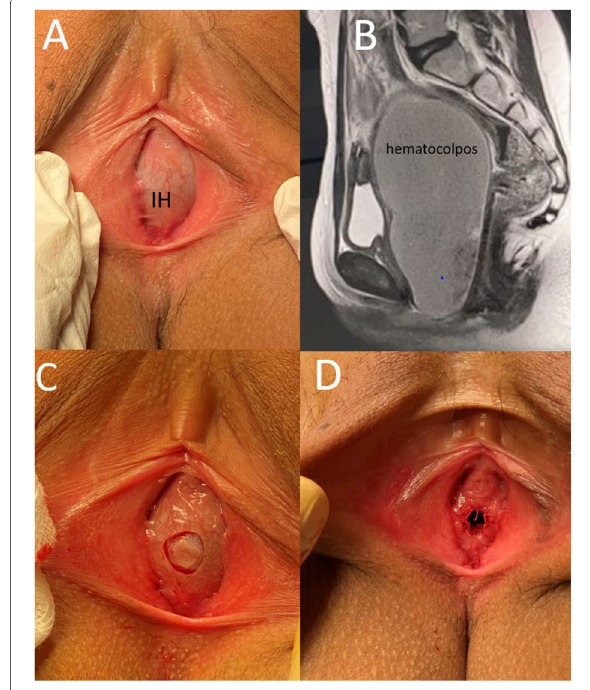
Fig. 1 Hymen-saving central annular hymenotomy (HSCAH) in adolescent. A Imperforated hymen (IH) with Valsalva maneuver showing increased bulging of imperforate hymen membrane. B Magnetic resonance image (MRI) showing massive hematocolpos occupying the pelvic cavity. C Demarcation of central annular incision. D Completed primary central annular excision of the hymenal membrane then suturing of the inner vaginal mucosa to external vestibular